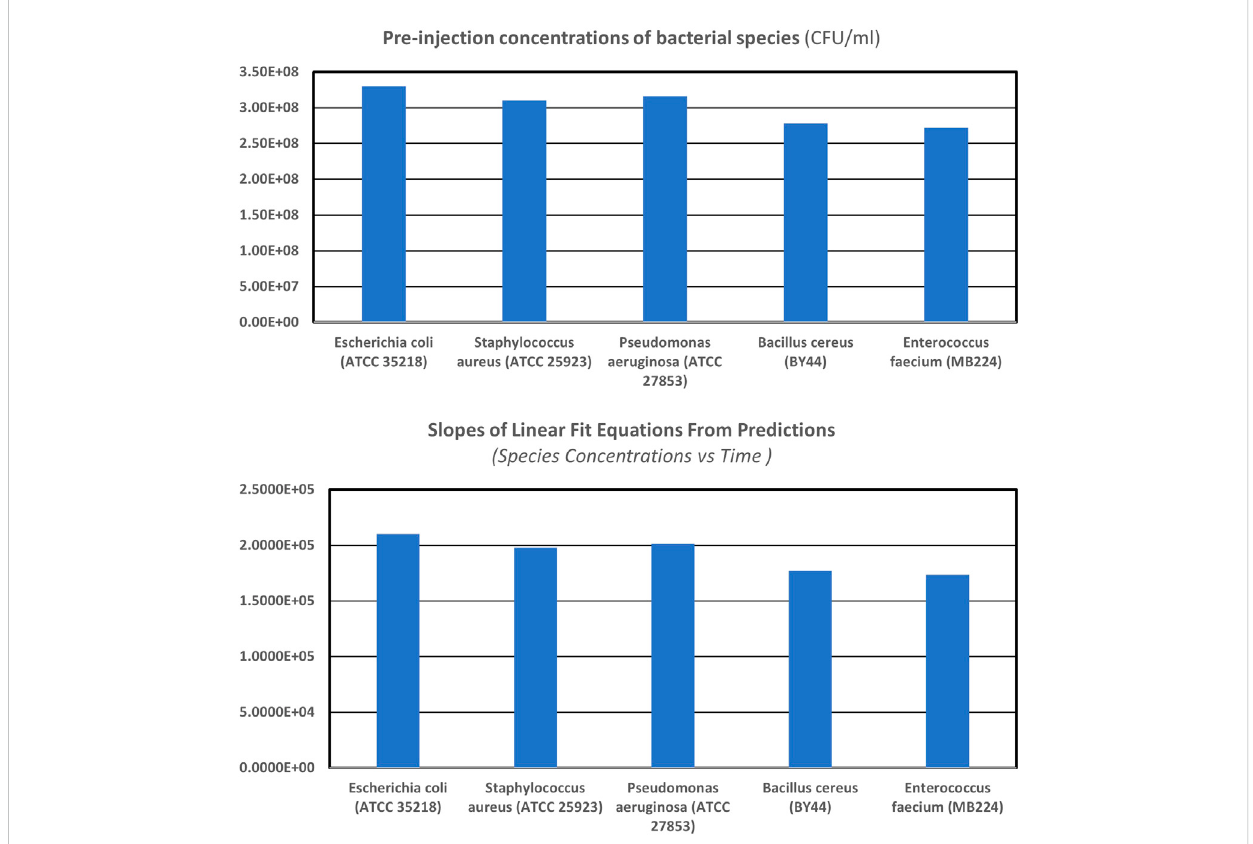
FIGURE 10 Pre-injection concentration ( CFU / ml ) plot of the individual species in Mixture 2 (top) and the plot of the slopes of the linear fi t equations (of species concentrations( CFU )asafunctionoftime)frompredictionsfor Mixture2 ,computedbythemachinelearningalgorithmbasedonthebackscattereddata from AUM system (bottom). The predicted slopes of the linear fi t equations of species concentrations as a function of time are consistent with the pre- injection concentrations of the individual species of the Mixture 2. The linear goodness of fi t, ( R 2 ) values of predictions are greater than